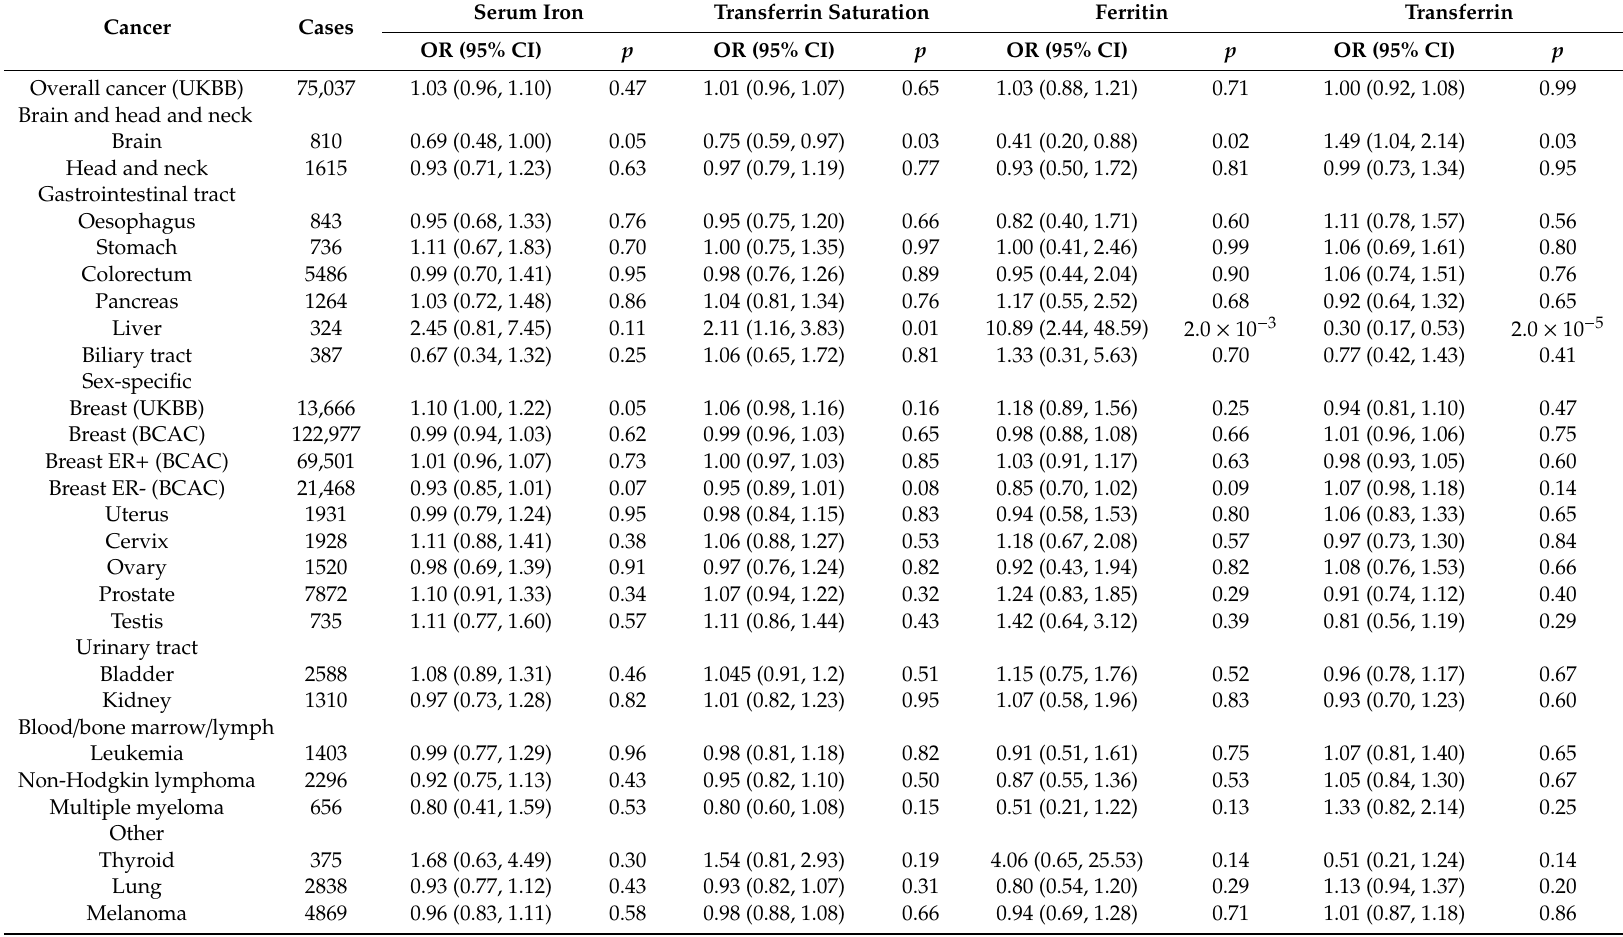
Table 2. Associations between genetically predicted iron status, based on three primary SNPs, and overall cancer and 22 site-specific cancers. Cancer